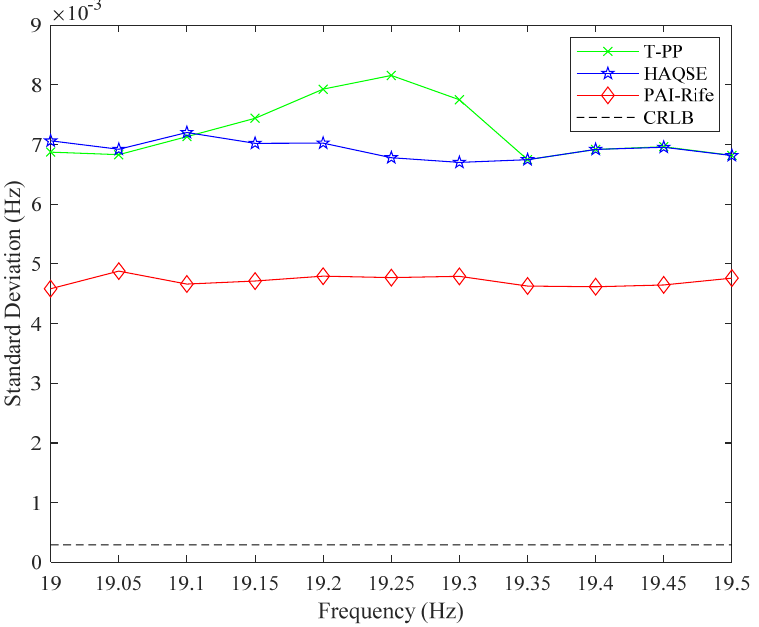
Figure 5. Standard deviation of PAI − Rife and other frequency domain estimation algorithms at different frequencies.